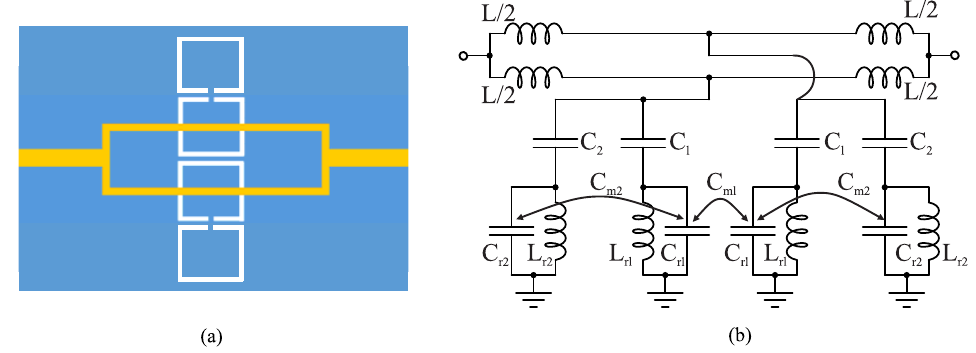
Figure 6. A splitter–combiner microstrip section loaded with a four-coupled CSRRs ( a ) footprint and ( b ) equivalent lumped circuit model. Reprinted with permission from Ref.